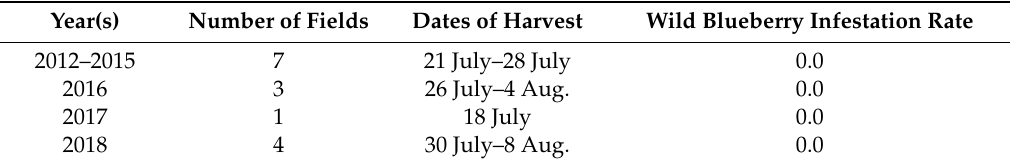
Table 4. Results of early harvest as a tactic for averting risk of fruit infestation by D. suzukii .